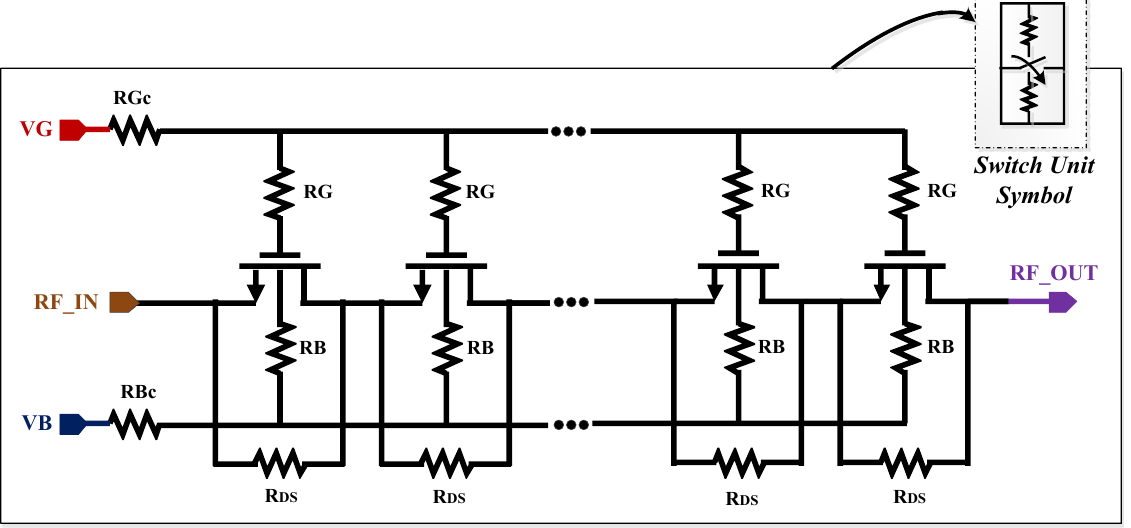
Figure 1. The utilized RF switch unit for series, shunt, and termination mode.